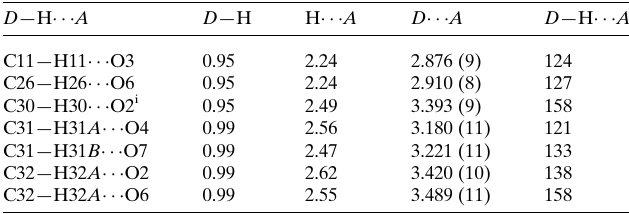
Table 2 Experimental details.